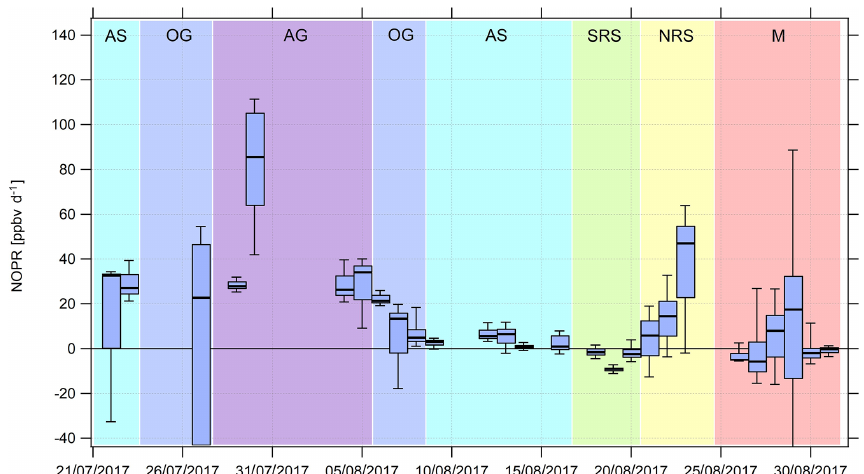
Figure 8. Timeline of the diurnal NOPR from 22 July to 31 August 2017. NOPR calculations are limited to the time period from 22 July onwards due to missing HO x data and contamination from the ship’s exhaust before this period. See Appendix A and the text for a list of the abbreviations used and a classification of the different regions, respectively.